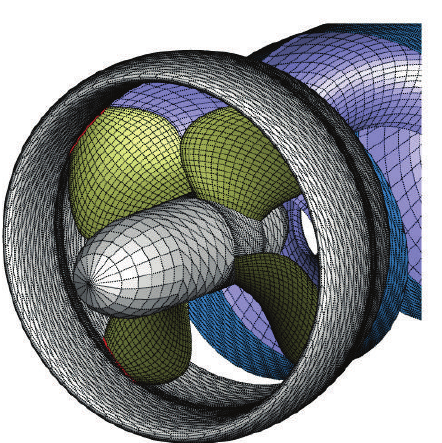
Figure 3: Panel representation of the ducted propeller. Tip gap region in